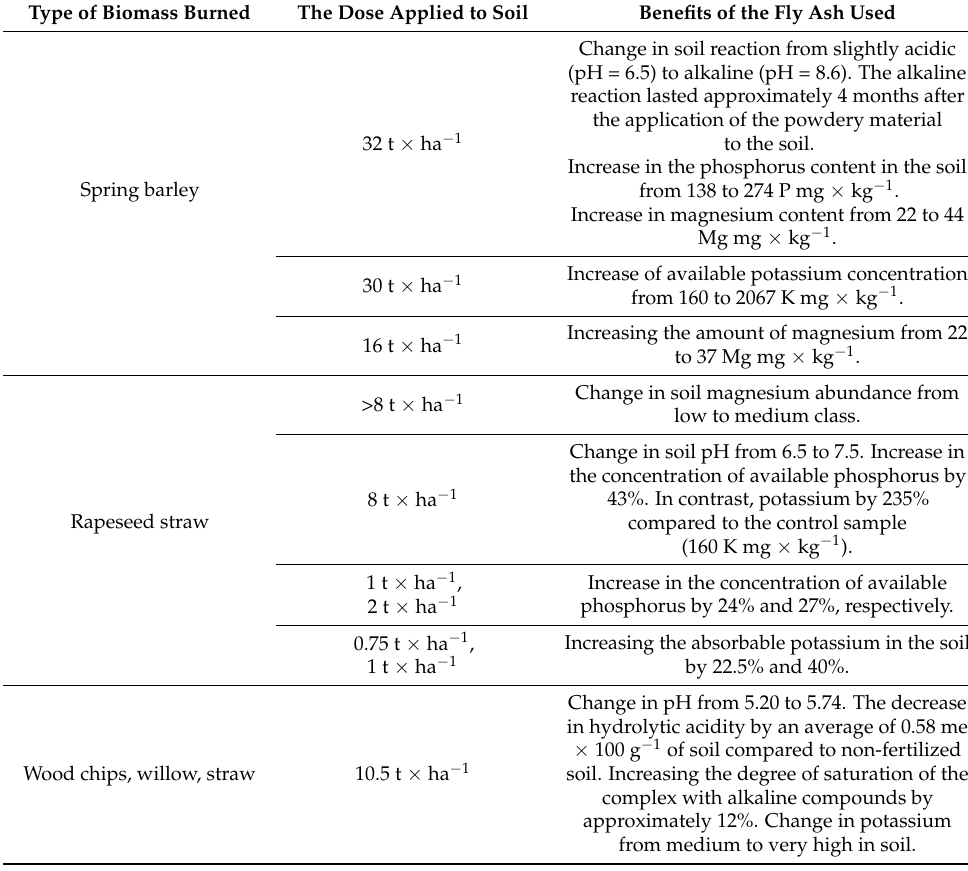
Table 6. Effect of dose and type of fly ash from biomass combustion on soil properties. Type of Biomass Burned The Dose Applied to